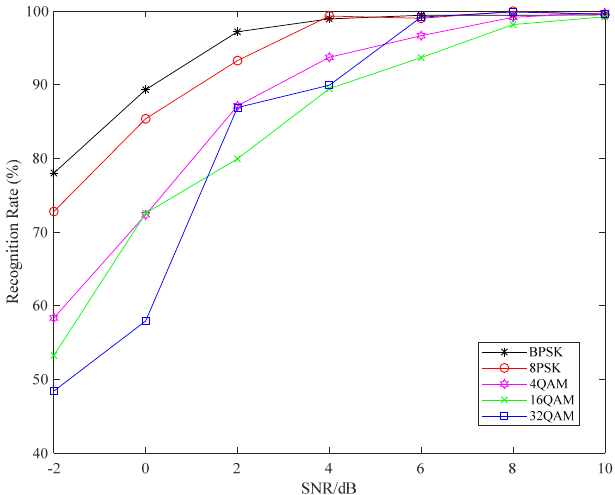
Figure 6. Recognition accuracy of KADPC algorithm for various digital signals. The confusion matrix calculated by KADPC algorithm when SNR = 4 dB is shown in Figure 7.